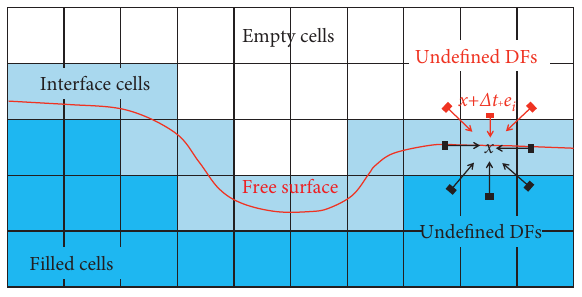
Figure 1: Cell types of SPFS-LB